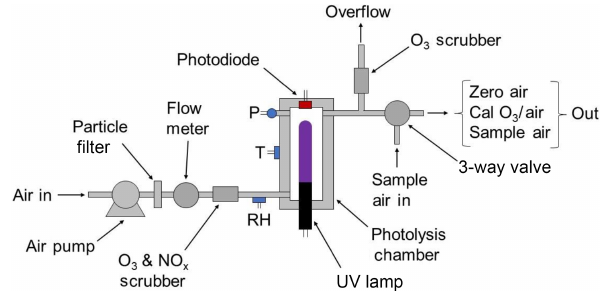
Figure 2. Schematic diagram of the 2B Technologies Model 306 Ozone Calibration